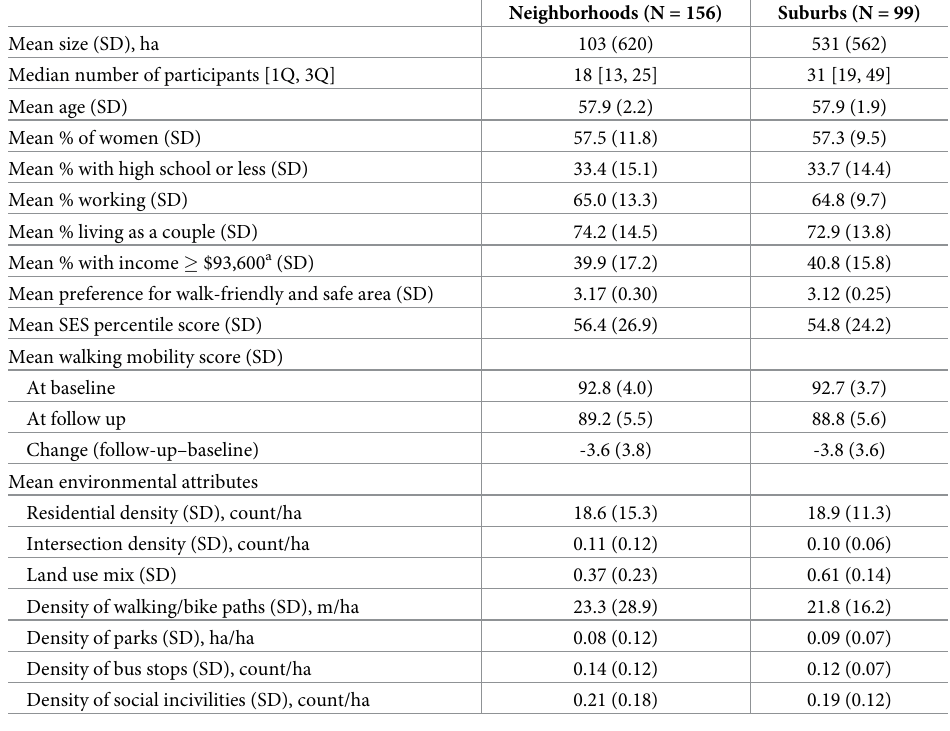
Table 1. Characteristics of neighborhoods and suburbs included in analyses.